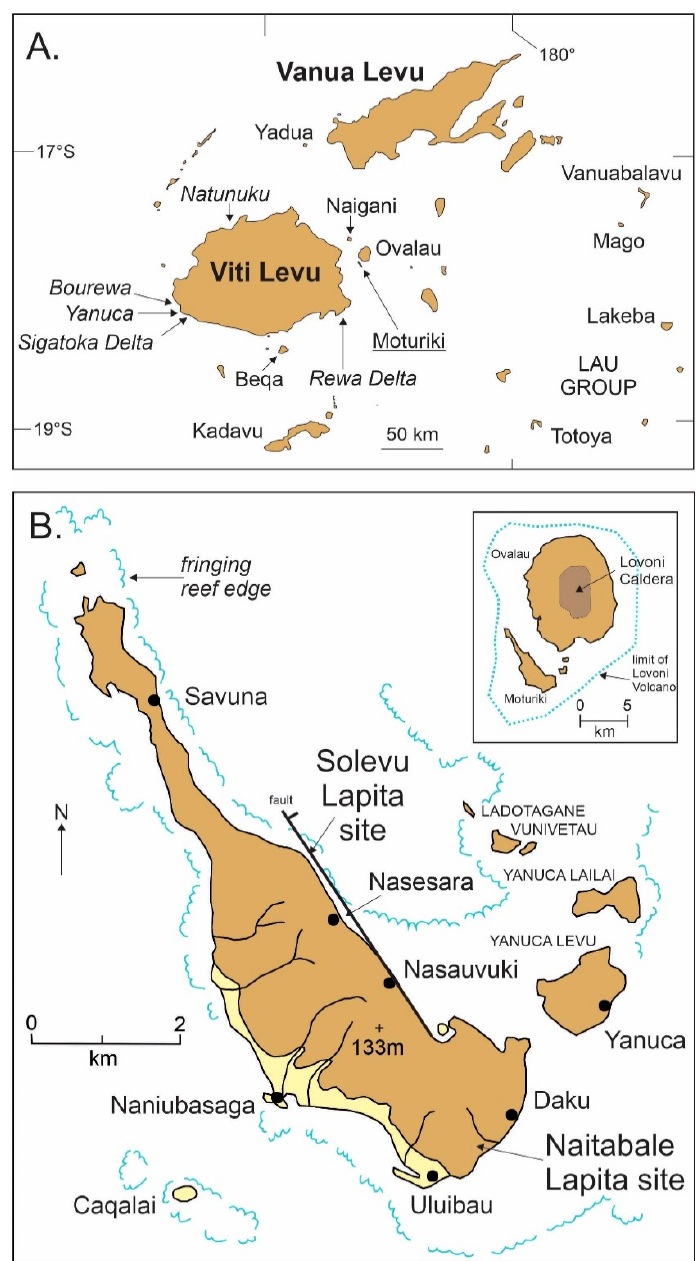
Figure 2. ( A )—Map of the Fiji Islands showing the locations of key Lapita-era sites. ( B )—Map of Moturiki, showing key features and the location of the Naitabale site where this study is based; inset shows the Lovoni Volcano of which Moturiki Island is part.